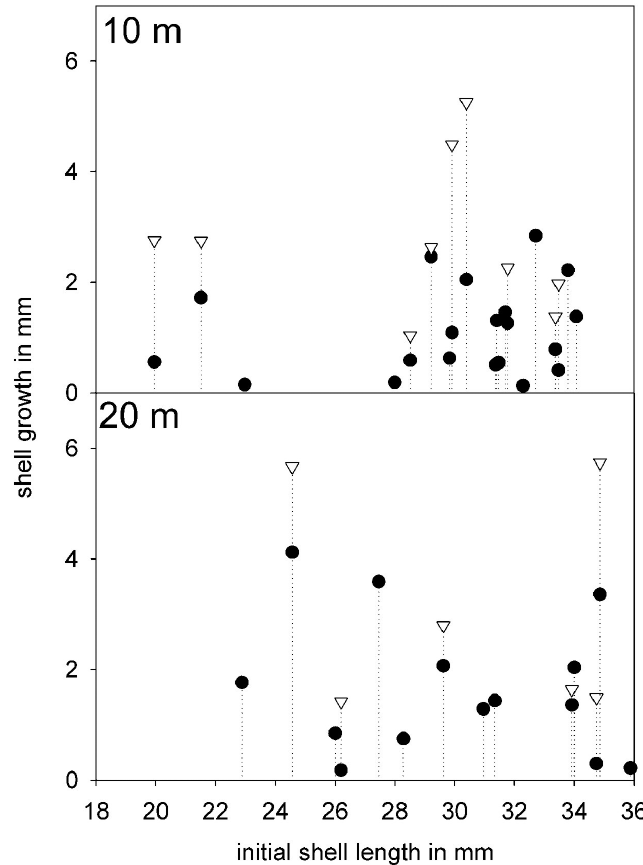
Figure 10. Individual growth rates of Calyptraea aurita after 165 (black circles) and 326 days (triangles) in 10 m and 20 m